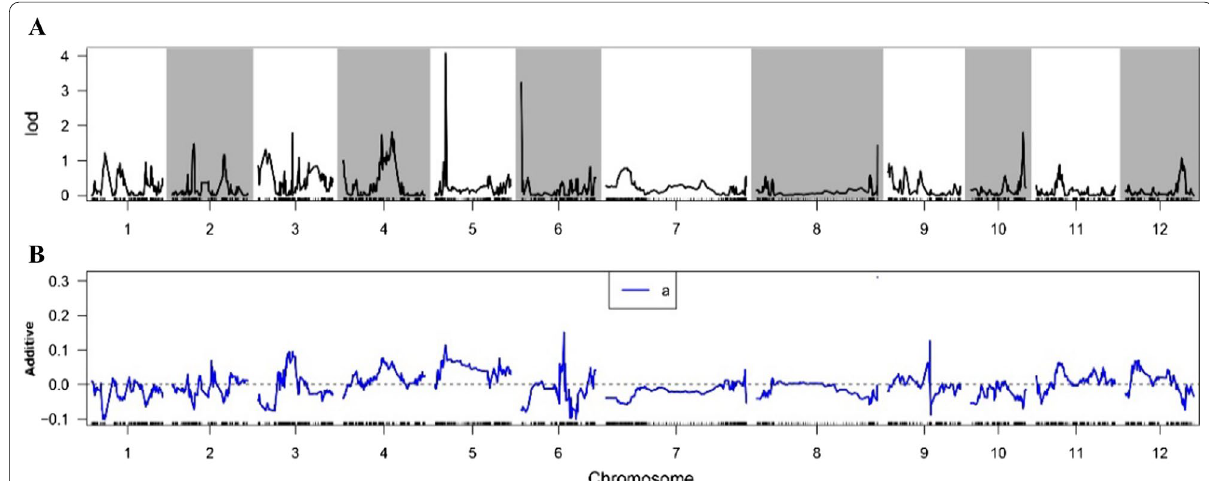
Fig. 1 QTL mapping result of survival rate from R/qtl. A Lod values of QTLs; B additive values of QTLs